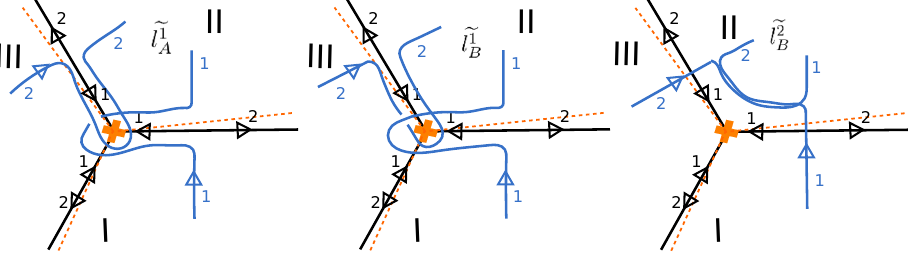
Figure 59 . Two lifts of l B which contribute the same as one lift of l A